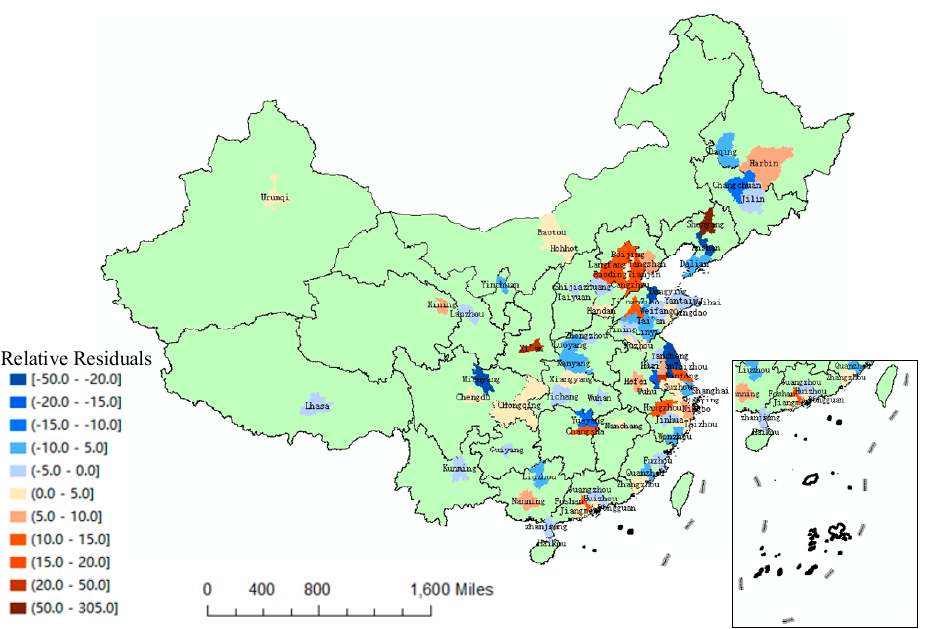
Figure 13. Distribution of 85 Chinese cities’ absolute residuals using OSM road network density and population.